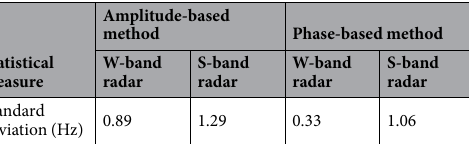
Table 3. Standard deviation of wingbeat frequency measurement errors for W-band and S-band radars. Note: These statistics of the differences between the stroboscope and radar measurement values are with one datum for each specimen (n = 13 for W-band and 7 for